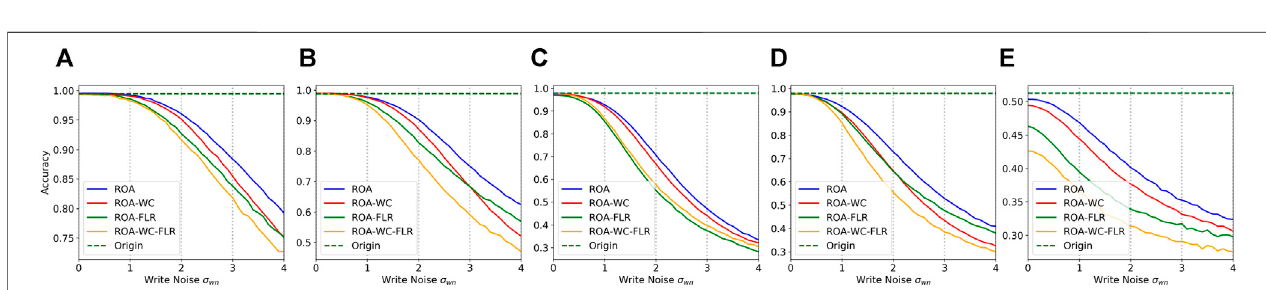
FIGURE 5 | Comparison of the accuracy of ROA, ROA without constraint (ROA-WC), no adjustment on learning rate (ROA-FLR) and baseline (ROA-WC-FLR) in different write noise. (A) 5way-1shot on Omniglot. (B) 10way-1shot on Omniglot. (C) 20way-1shot on Omniglot. (D) 20way-1shot with the wider network on Omniglot. (E) 5way-1shot on